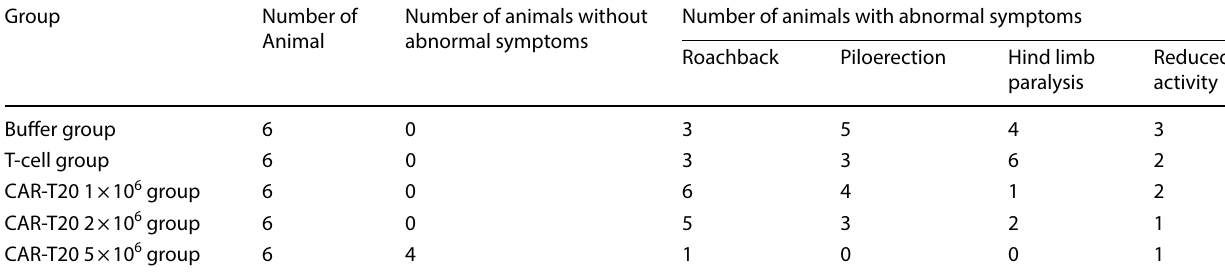
Table 1 Summary of clinical